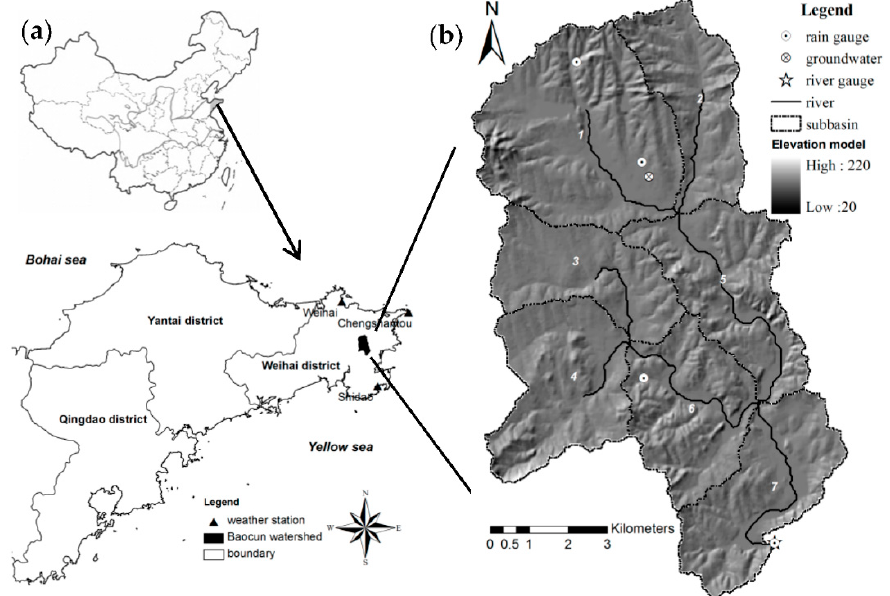
Figure 1. Location and topography of the Jiaodong peninsula ( a ) and the Baocun watershed ( b ) as well as the position of gauging stations.